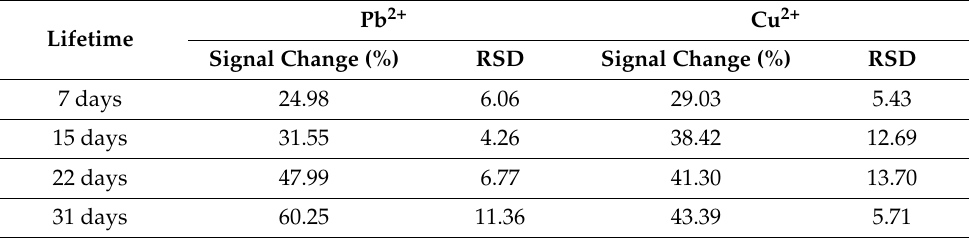
Table 4. Lifetime measurement of TC4/AuNPs/SPCE in the detection of 1.0 ppm of Pb 2+ and Cu